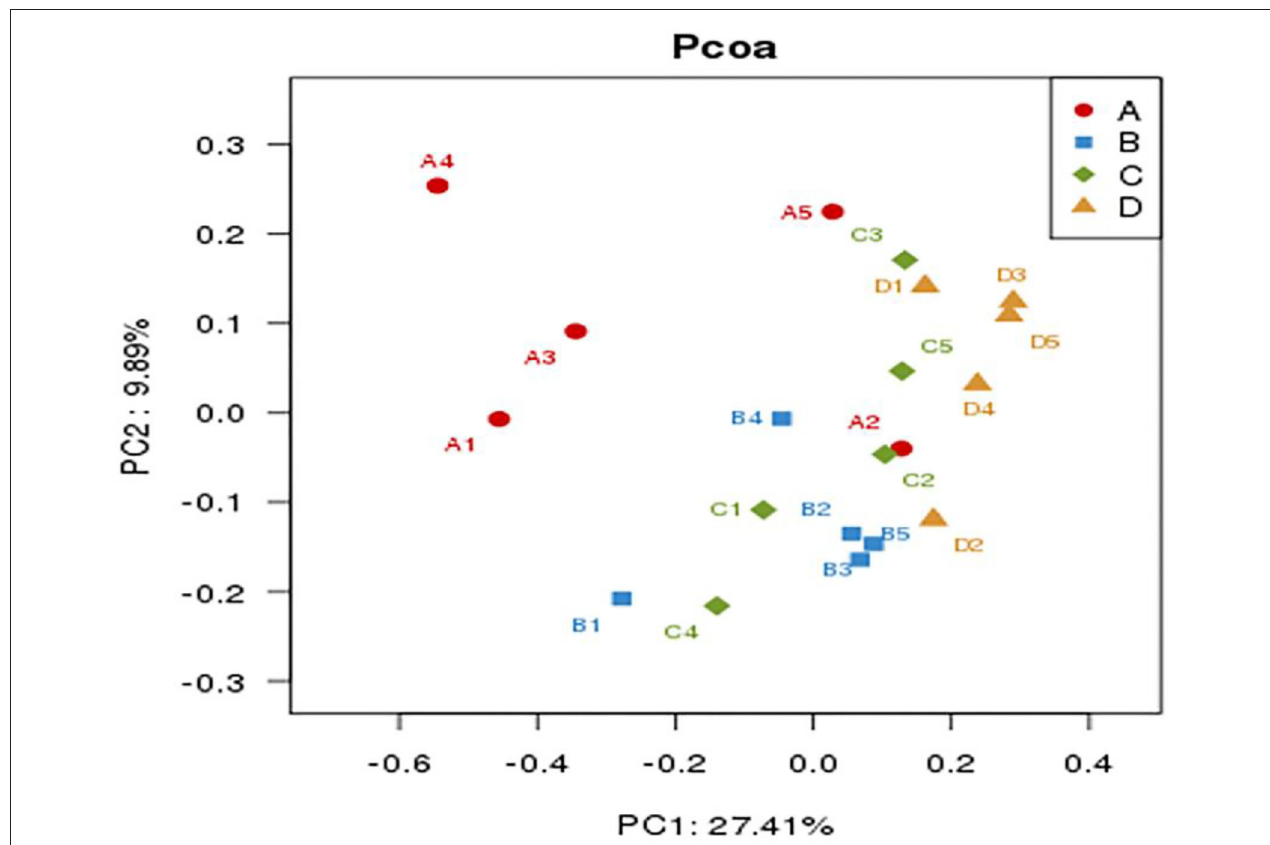
FIGURE 4 | Comparison of caecum microbiota compositions of weaned piglets by principal component analysis (PCoA) ( n = 5). Group A (A1–A5): the control diet supplemented with 25 mg/kg quinocetone and 11.25 mg/kg chlortetracycline in the basal diet; Group B (B1–B5): 200 mg/kg bacteriophage diet; Group C (C1–C5): 400 mg/kg bacteriophage diet; Group D (D1–D5): 600 mg/kg bacteriophage diet. To determine the statistical differences in beta-diversity of bacterial communities among treatment groups, the PERMANOVA (Adonis procedure with 999 permutations) was performed to calculate P -values. There were significant difference between group A and group B ( R 2 = 0.191, P = 0.017), group A and group C ( R 2 = 0.234, P = 0.018), group A and group D ( R 2 = 0.227, P = 0.015), group B and group D ( R 2 = 0.155, P = 0.042), as well as group C and group D ( R 2 = 0.222, P = 0.017). No significant difference between group B and group C was found ( R 2 = 0.115, P =